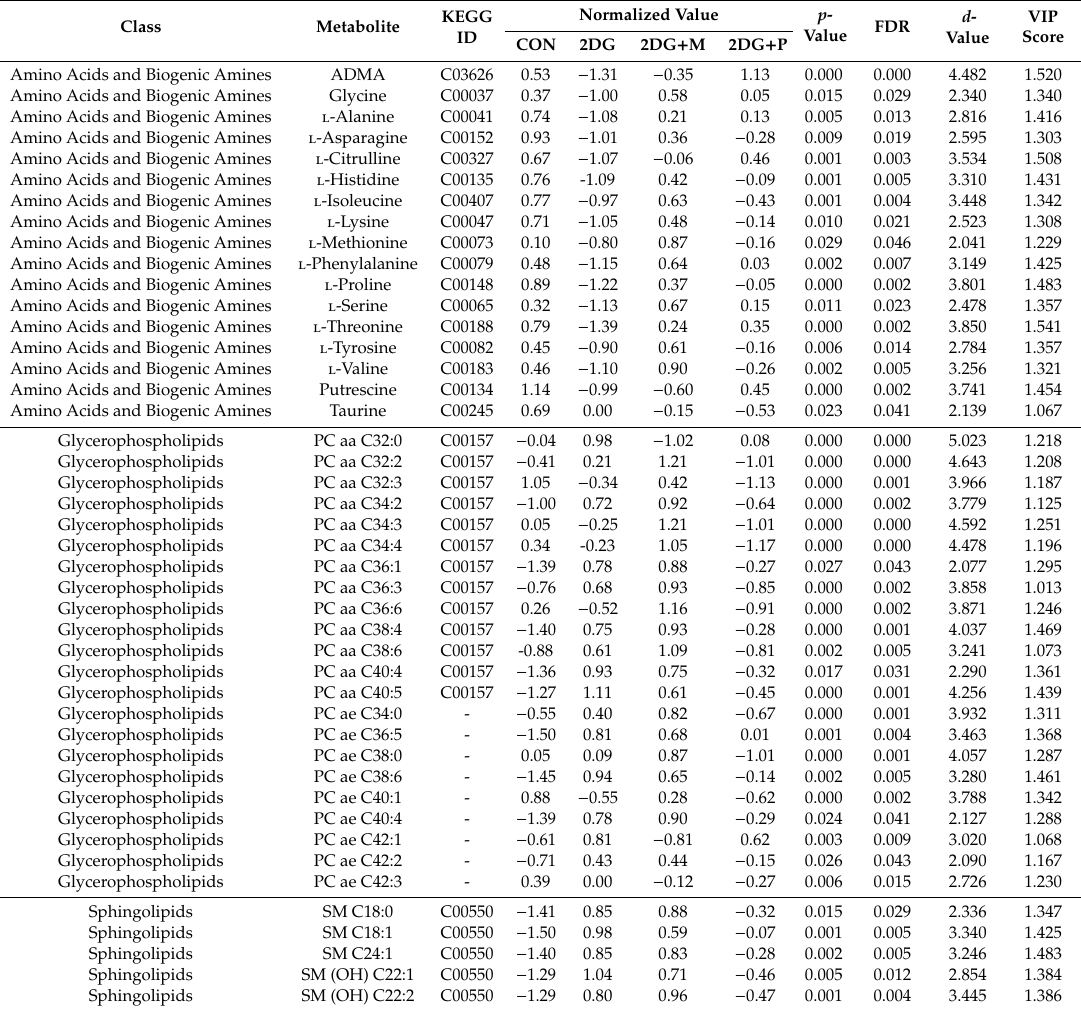
Table 1. List of altered metabolites by PLS-DA, ANOVA and SAM